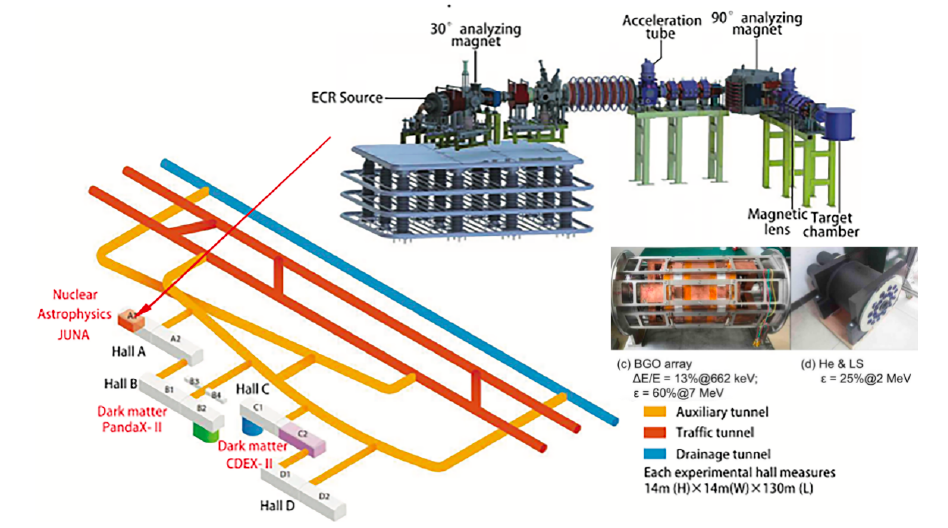
Figure 1. The layout of JUNA in